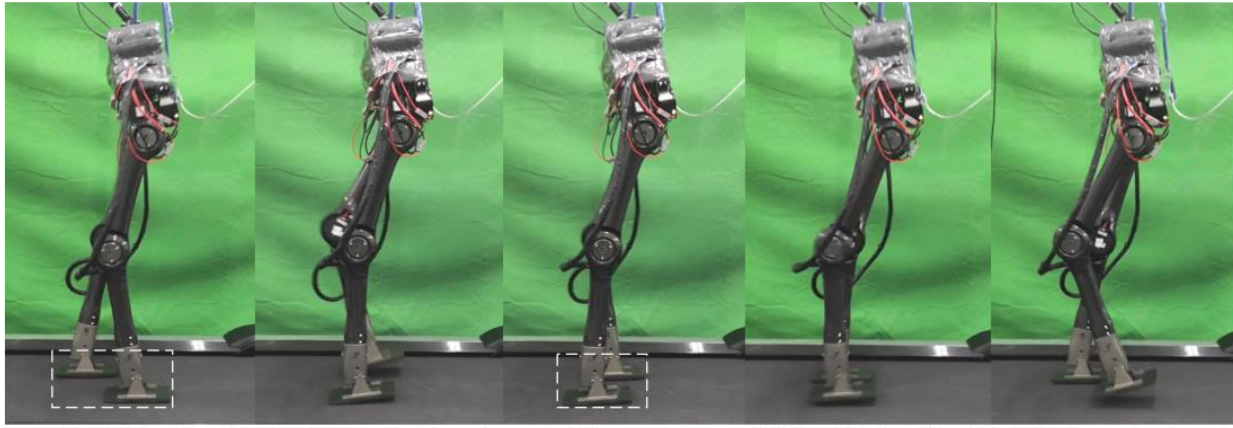
Figure 9. Five key frames of non-symmetrical walking experiment.